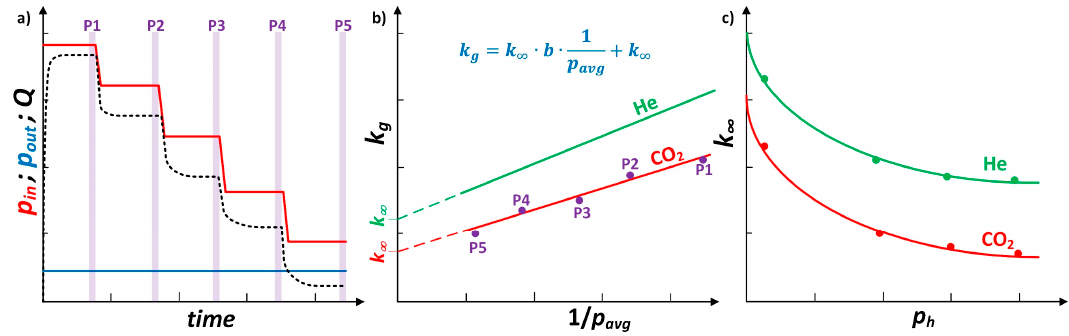
Figure 5. Schematic diagrams of the changes in p in , p out , and Q parameters ( a ), the method of determining the Klinkenberg permeability coefficients (cid:1863) (cid:2998) ( b ), and the relationship (cid:1863) (cid:2998) ((cid:1868) (cid:3035) ) ((cid:1803)) .